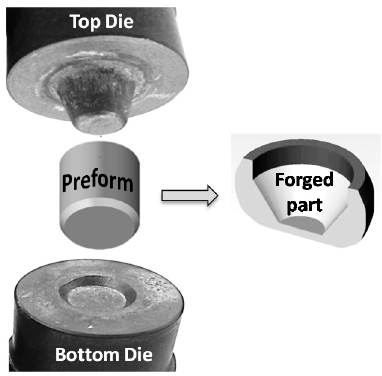
Figure 11. Sketch showing the configuration of the dies used for forging the workpiece (preform) to produce a rib-web (cup) shape component.